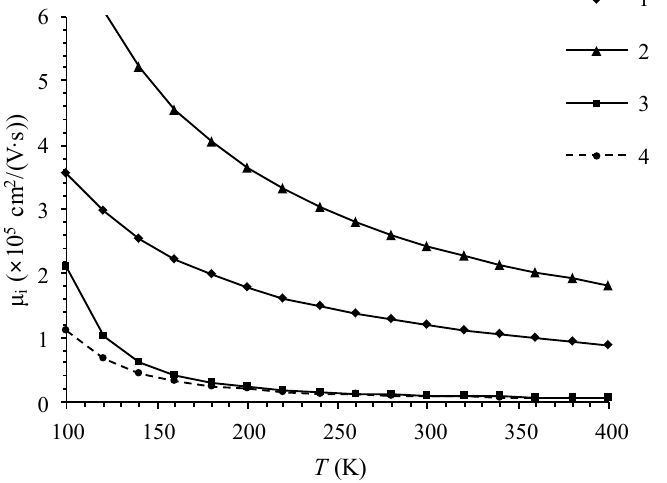
Fig. 2. Temperature dependence of the two-dimensional electron gas for n = 2×10 12 cm -2 : 1 – acoustic deformation potential scattering, 2 – polar acoustic phonon scattering, 3 – polar optical phonon scattering, 4 – combined